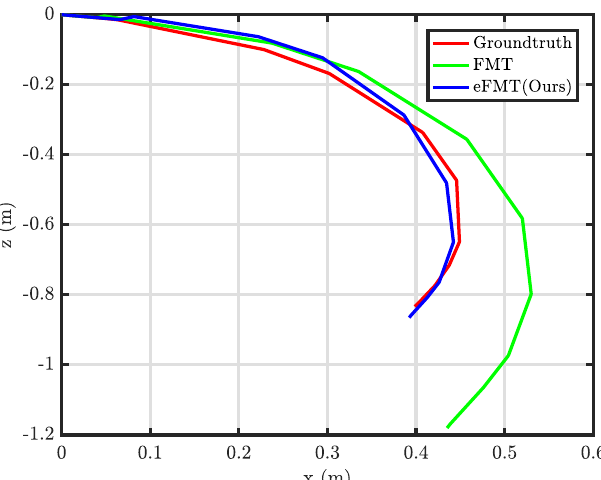
Figure 10. Visual odometry comparison in a simulated scenario. The data is collected with the setting in Figure 8.